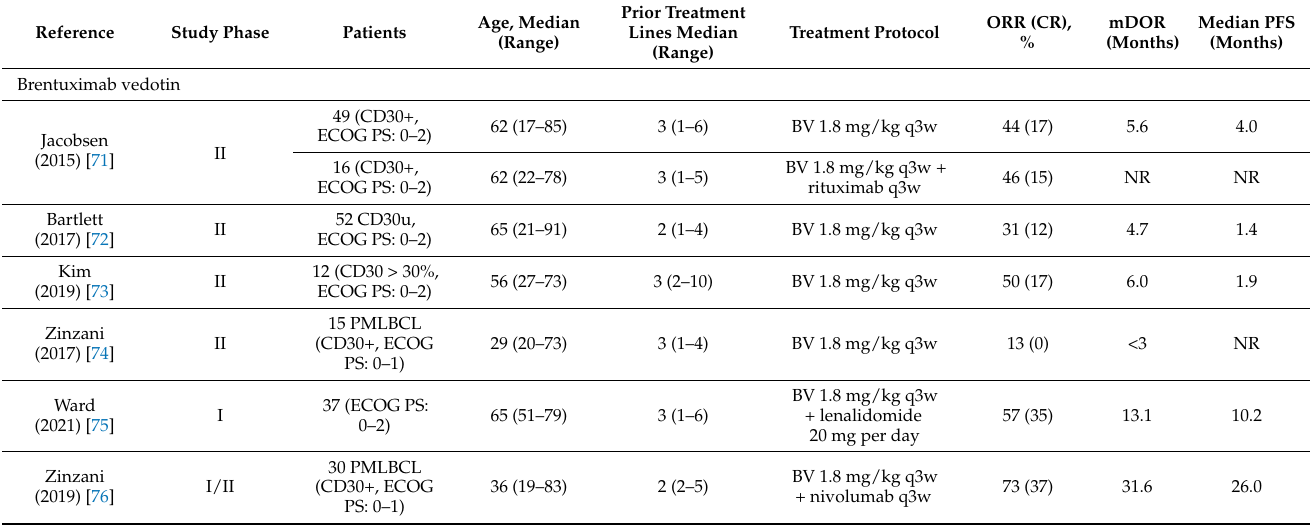
Table 4. Clinical trials evaluating the efficacy of commercially available antibody-drug conjugates in R/R